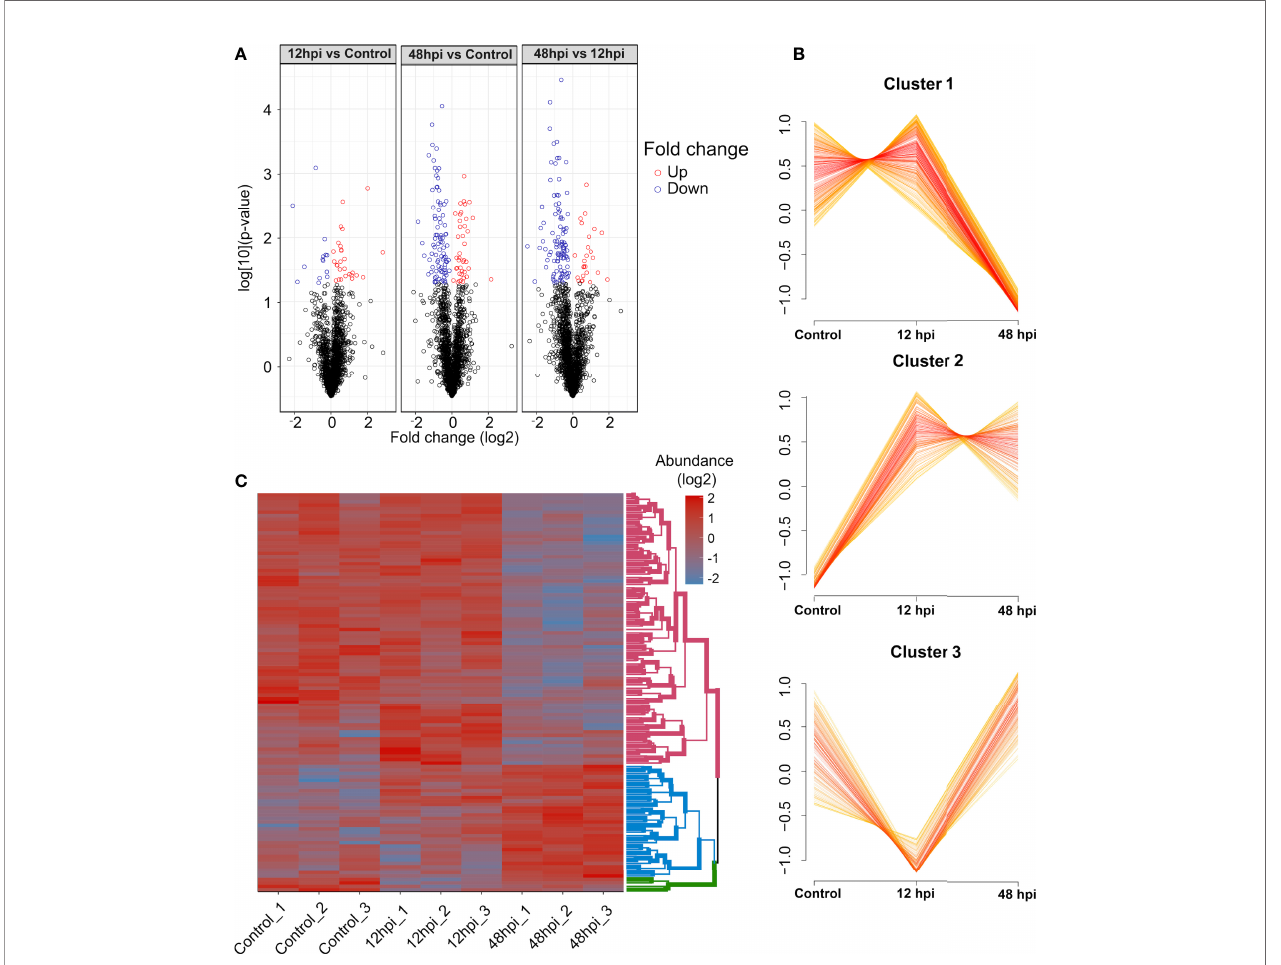
FIGURE 4 | Quantitative overview of abundance variation of protein groups during chikungunya virus (CHIKV) infection of Aedes aegypti Aag-2 cells. (A) Volcano plot highlighting regulated protein groups analyzed by one-way ANOVA with post-hoc Bonferroni multiple test correction (p-value < 0.05) from 1,951 protein groups analyzed. (B) Clusters of abundance pro fi les of 1,129 protein groups were obtained in VSClust. (C) Heatmap of 116 protein groups without missing values clustered according to their abundance